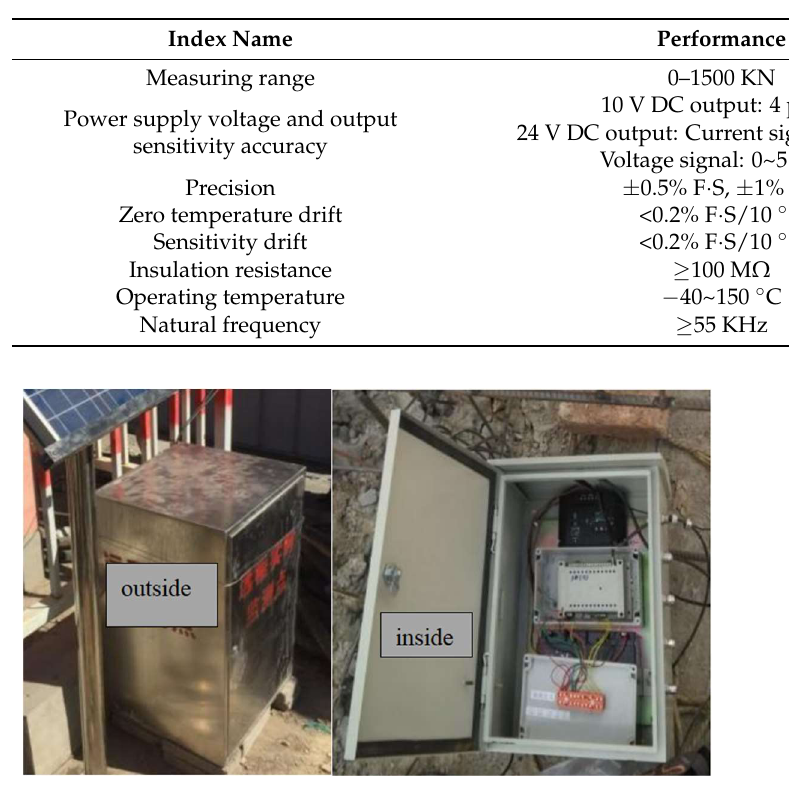
Figure 3. Sensors for measuring force and deformation. Table 2. Technical parameters of NPR cable.